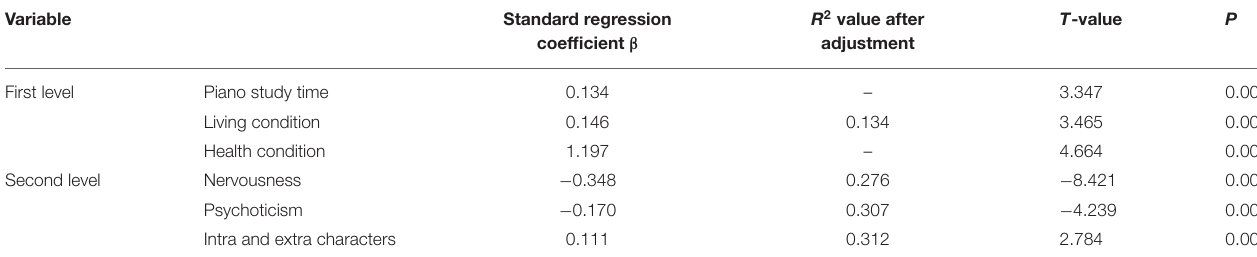
TABLE 8 | Multiple stratified stepwise regression analysis of subjective well-being